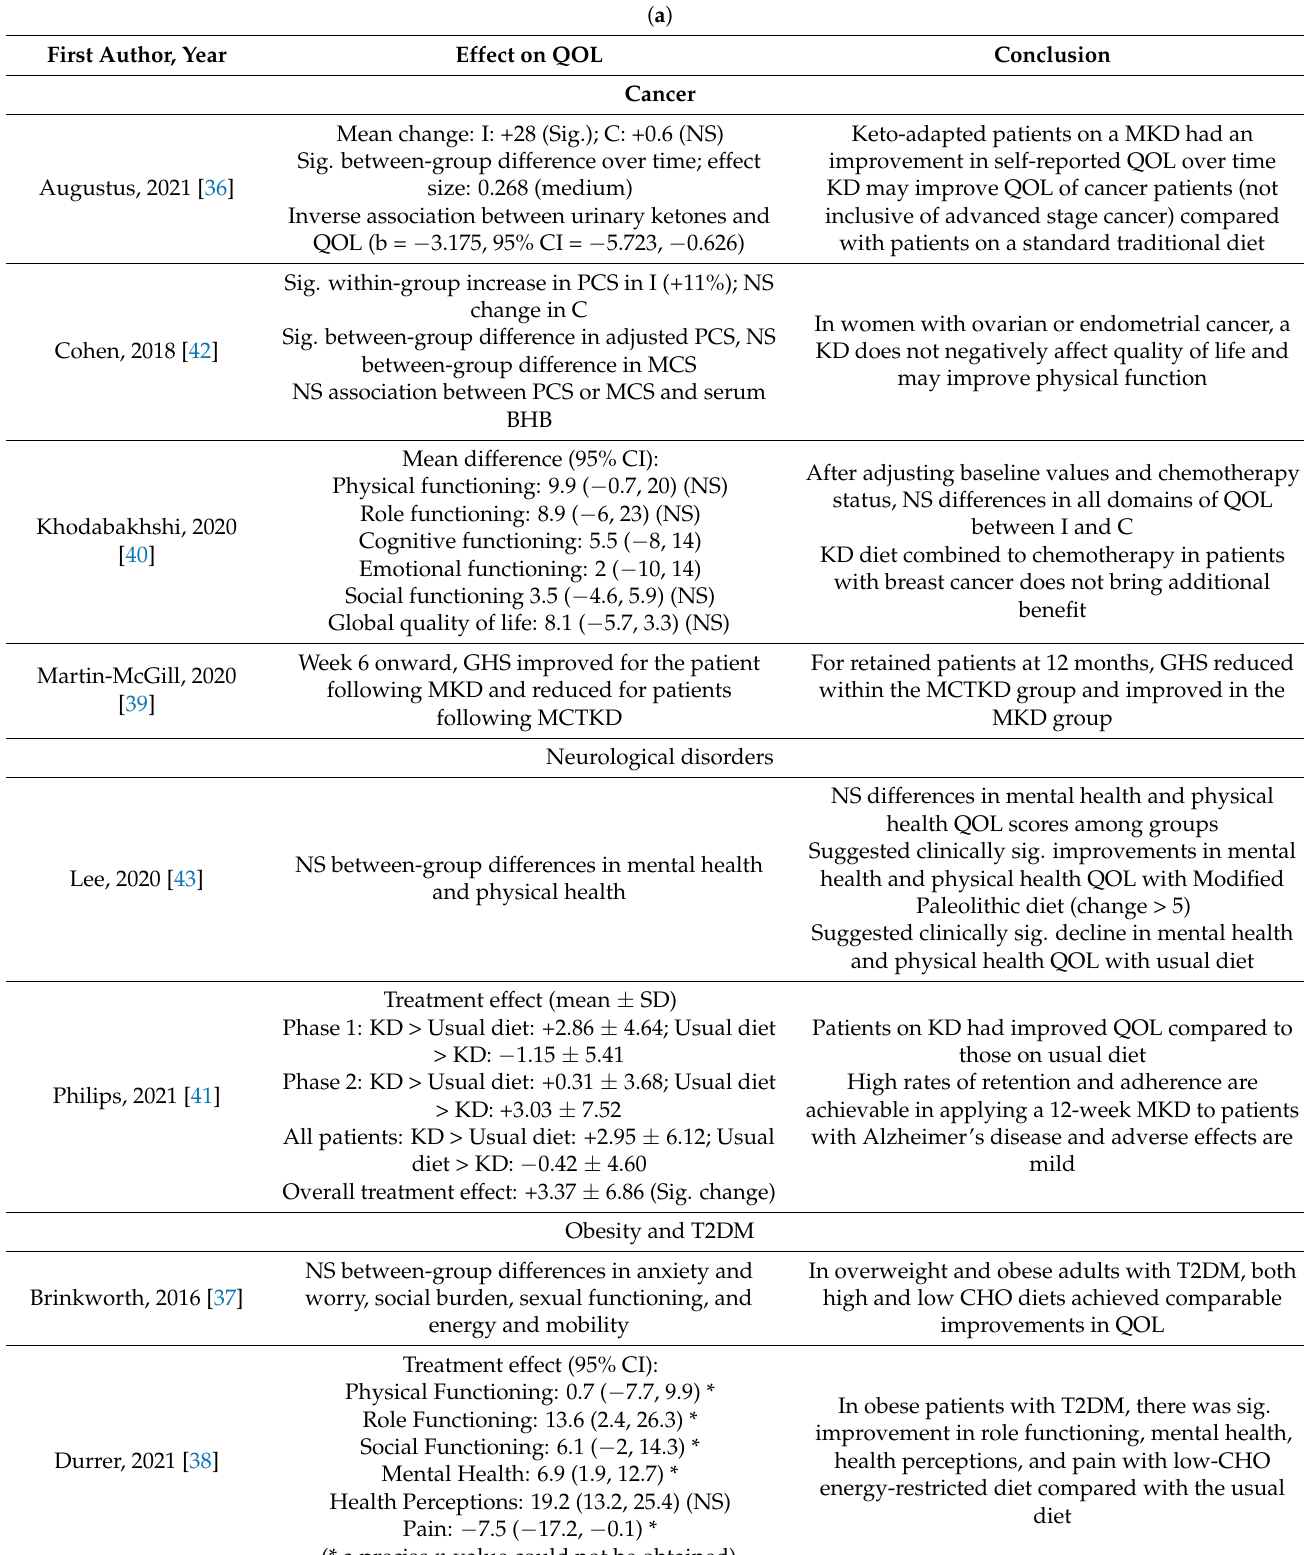
Table 2. ( a ) Results of included studies. ( b ). Results of included studies. ( a